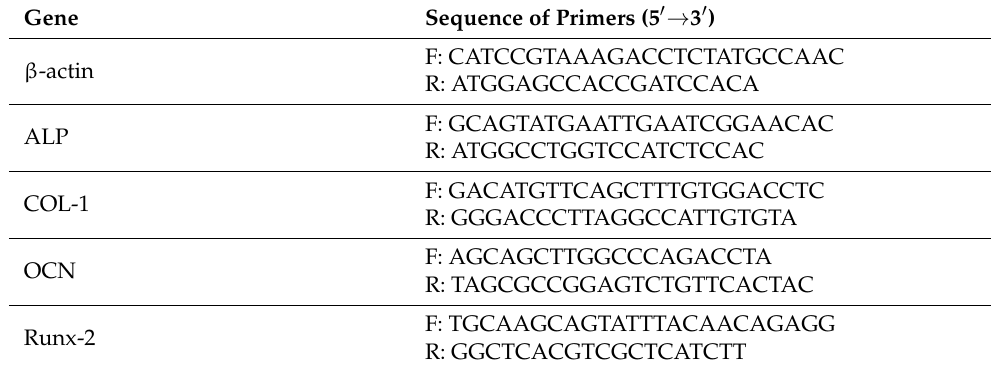
Table 2. Primer sequence for qRT-PCR in osteogenesis